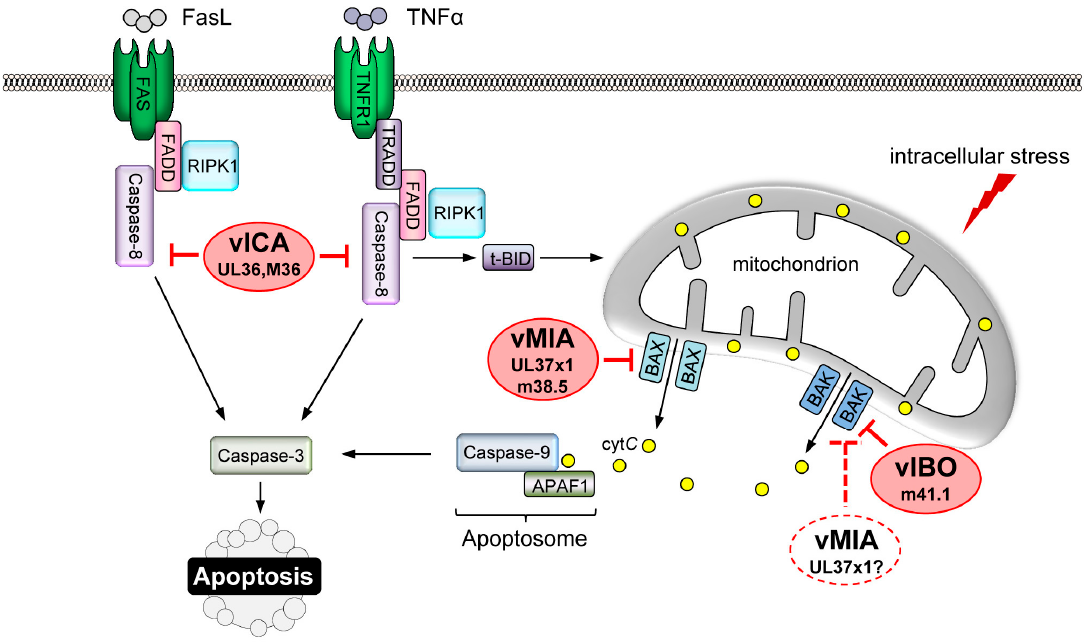
Figure 1. Inhibition of apoptosis by cytomegalovirus (CMV). The viral mitochondria-localized inhibitor of apoptosis (vMIA) and the viral inhibitor of BAK oligomerization (vIBO) inhibit mitochondrial outer membrane permabilization and release of proapoptotic factors (such as cytochrome C (cyt C )) by interacting with BAX and BAK, respectively. While murine CMV (MCMV) encodes two specific inhibitors, m38.5 and m41.1, human CMV (HCMV) has only one inhibitor, UL37x1. Whether the UL37x1 protein is BAX-specific or inhibits both BAX and BAK remains controversial. The extrinsic apoptosis pathway initiated by death receptor stimulation is blocked by the viral inhibitor of caspase-8 activation (vICA), which is encoded by the HCMV UL36 and the MCMV M36 gene, respectively. FasL: Fas ligand; FADD: Fas-associated death domain protein; RIPK1: receptor interacting protein kinase-1; TNF α : tumour necrosis factor α ; TNFR1: TNF receptor 1; TRADD: TNFR1-associated death domain protein; t-BID: truncated BH3-interacting domain death agonist; APAF1: apoptotic protease activating factor